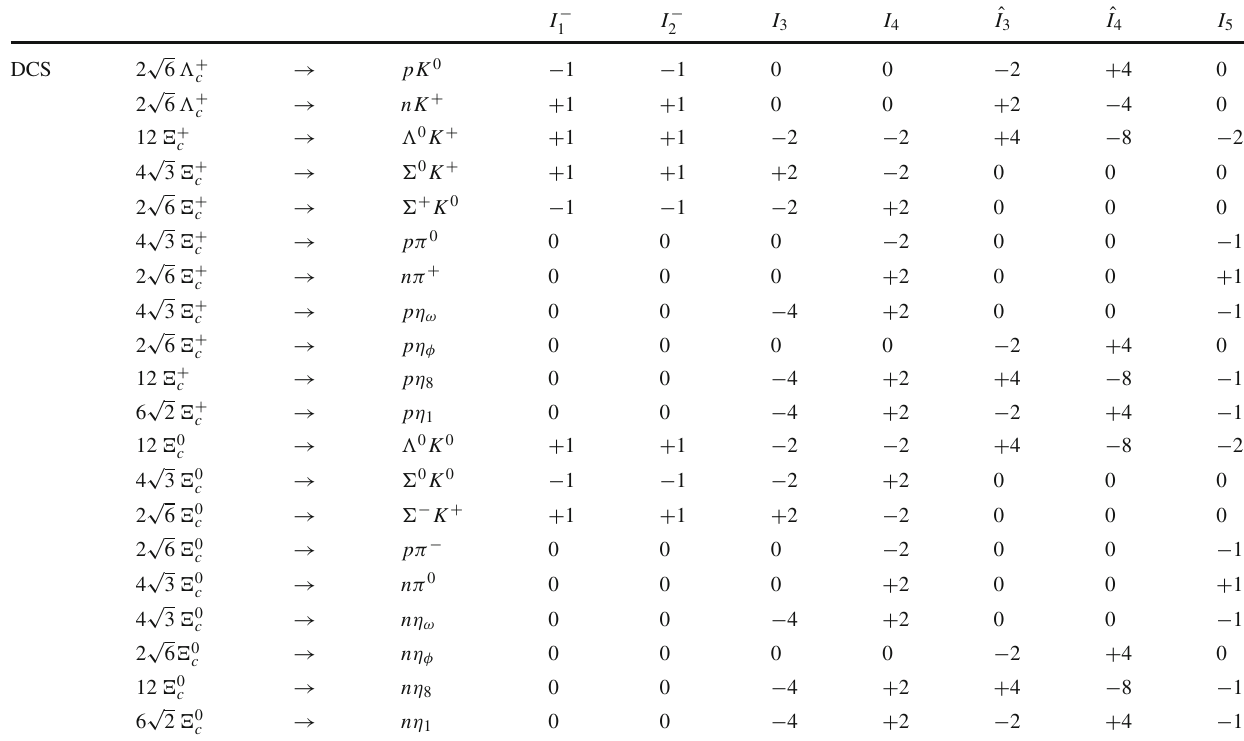
Table 7 Values of the seven topological tensor invariants for the DCS antitriplet charm baryon decays B c ( 3 ) → B ( 8 ) + M ( 8 , 1 ) induced by the flavor transition ( c → d ; s → u )